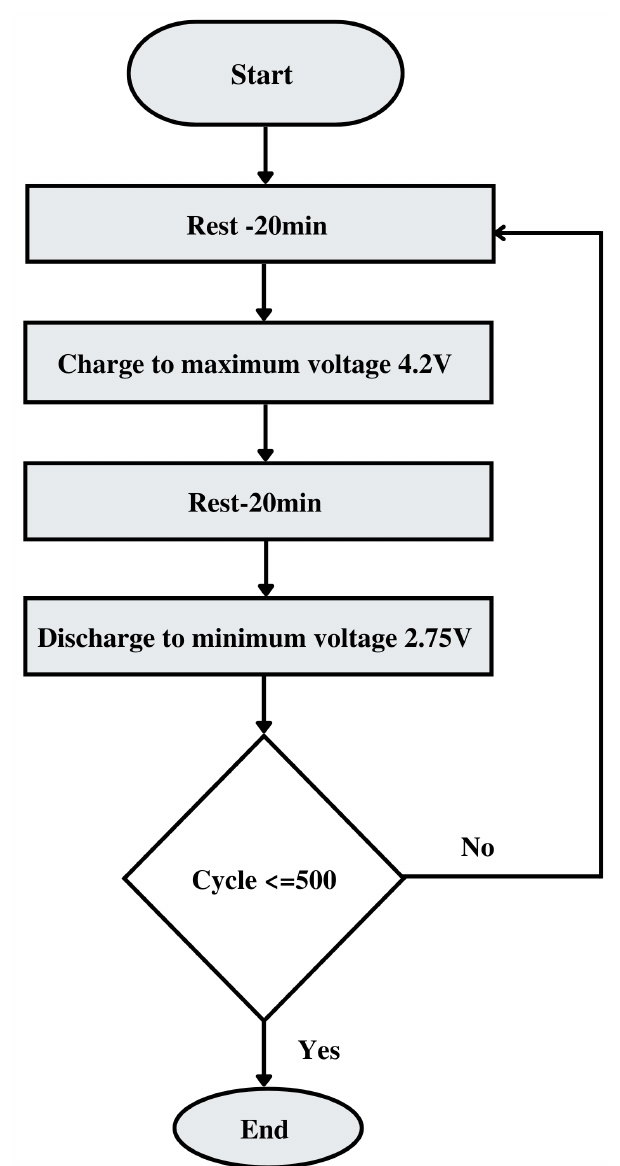
Figure 3. Flowchart of the battery cycle life test for 500 cycles. In this configuration, one cycle consists of charging the battery to its highest voltage of 4.2 V and then discharging it to its minimum value of 2.75 V.